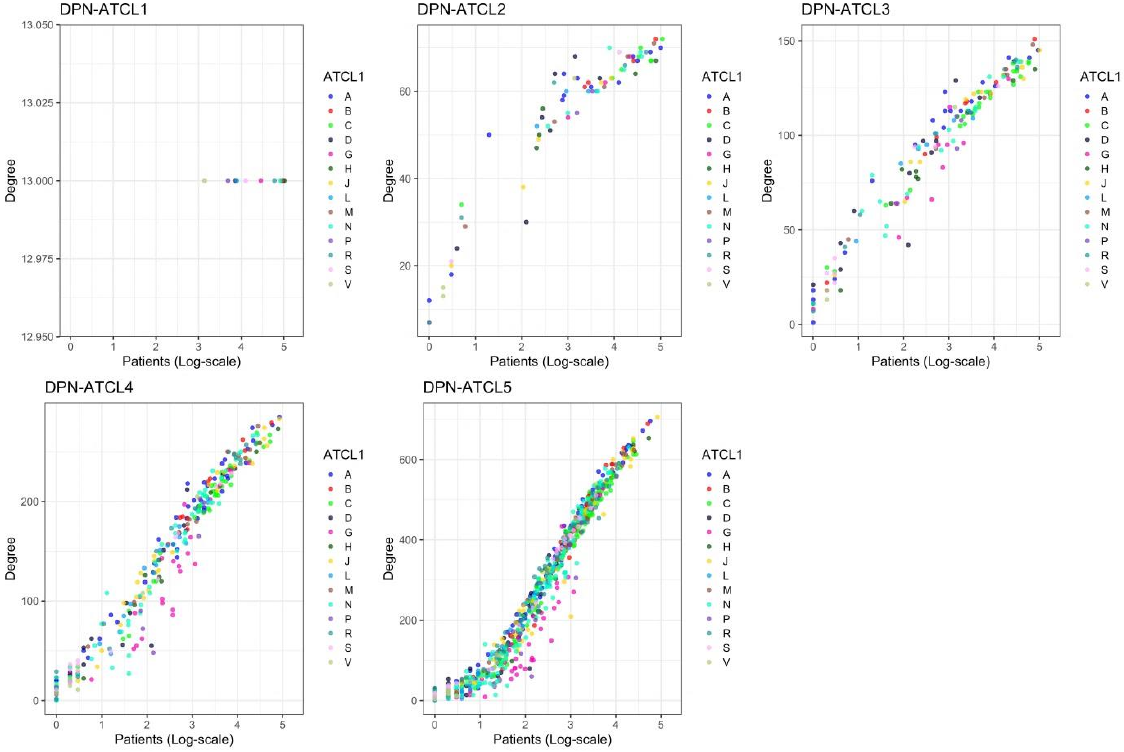
Figure 5. Relationship between number of prescriptions and variety of co-prescriptions. Scatter plots display the relationship between the number of patients prescribed with an ATC i and the number of neighbours of that ATC i in the drug prescription networks. Nodes are coloured according to the 14 groups found at the first level of the ATC classification system.